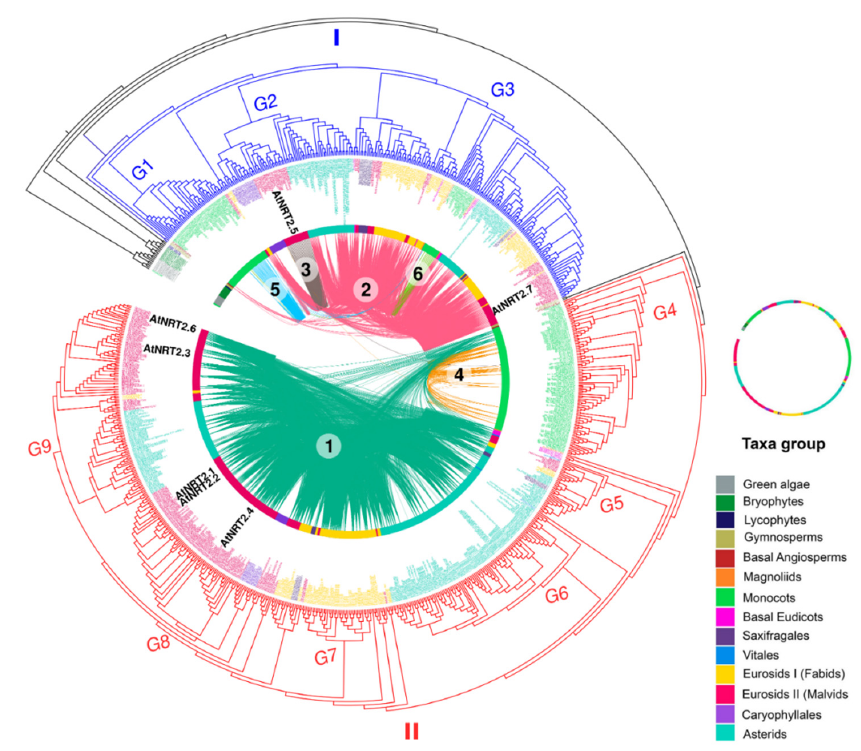
Figure 5. Phylogenetic tree of NRT2 gene family. From the outside to the center: tree of maximum circular likelihood of the NRT2 genes in which syntenic relationships were detected. The intermediate ring represents the different taxonomic groups where the genes are represented with different colors. Concentric lines represent the different communities of syntenic genes (distinguishable by color and assigned number) and the connections of each pair of genes are represented using curved lines. Syntenic connections are established between the same community or between different communities. The image depicts the location of NRT2 genes of A. thaliana